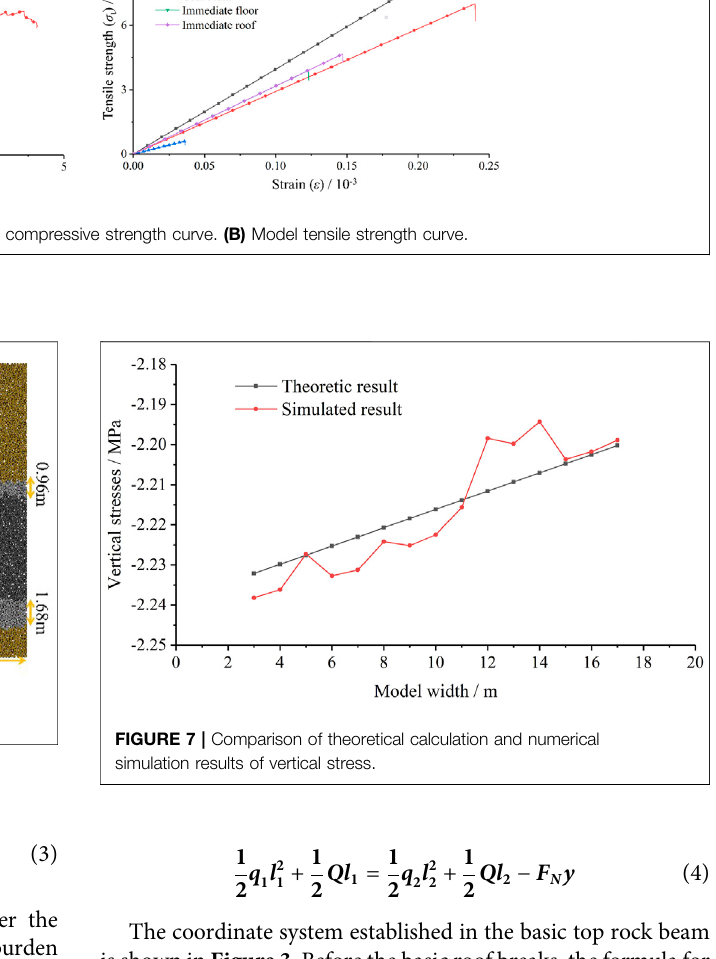
TABLE 2 | Input parameters of PFC 2D model for each rock stratum. Ground layer